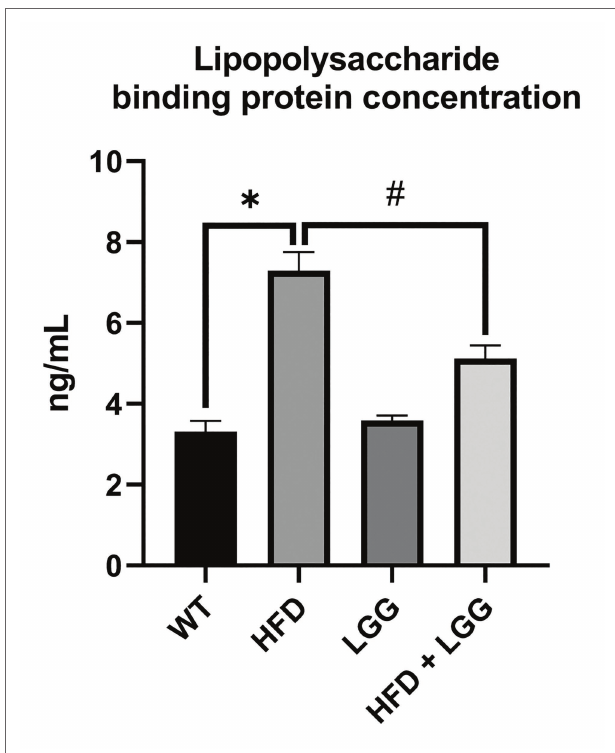
FIGURE 4 | Effect of HFD and LGG treatment on the lipopolysaccharide binding protein concentration in mice serum (ng/ml). WT, Wild-type C57BJ/L6 mice; HFD, HFD-supplemented wild-type mice; LGG, LGG-supplemented wild-type mice; HFD + LGG, HFD, and LGG-supplemented wild-type mice. All data represent means ± SD, WT vs. HFD group * p < 0.05; HFD vs. HFD + LGG # p < 0.05, n =